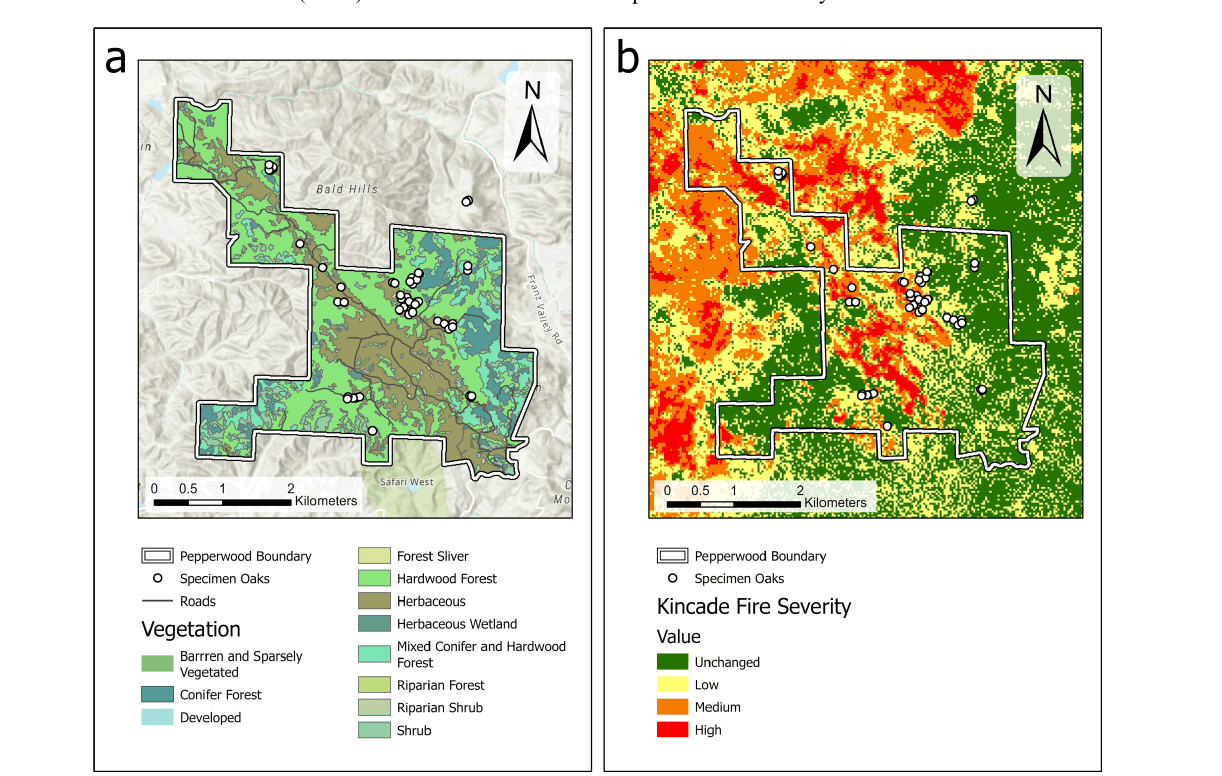
Fig. 2 . Maps of the specimen oaks identified at Pepperwood Preserve with respect to (a) local species alliances and (b) fire severity during the 2019 Kincade Fire. Sentinel-2 data was used to extract the relativized burn ratio (RBR) from the Kincade fires to represent burn